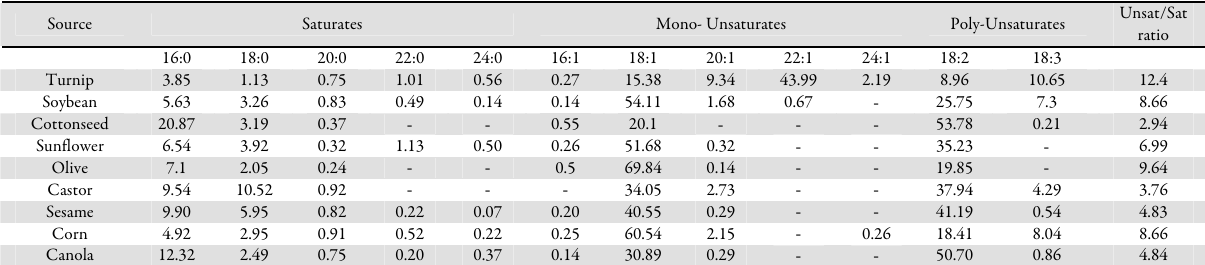
Tab. 3. Fatty acid composition of vegetable oils